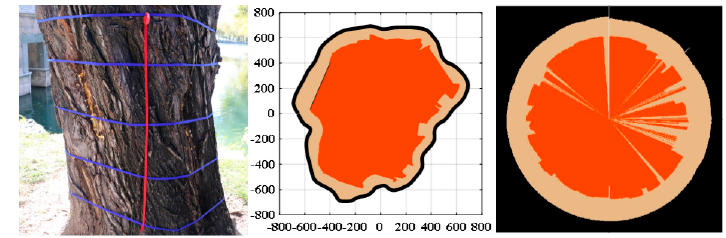
Figure 11. Detection result of tree L01 in the Summer Palace. Table 3. Field experiment results.